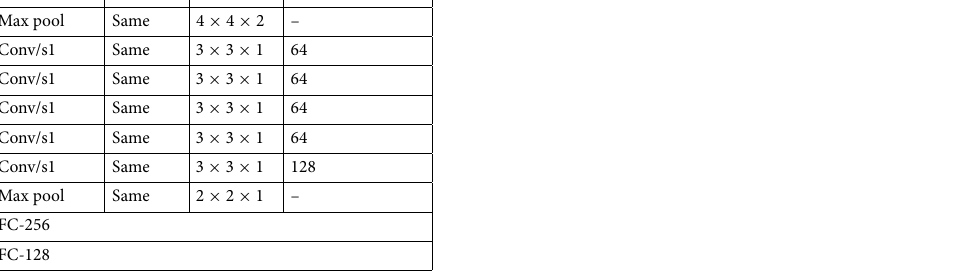
Table 3. 3D-CNN network architecture. The input of the 3D-CNN is 3-D histograms H ∈ R 3-D convolution operation is performed over the ‘time’, ‘bin’, and ‘band’